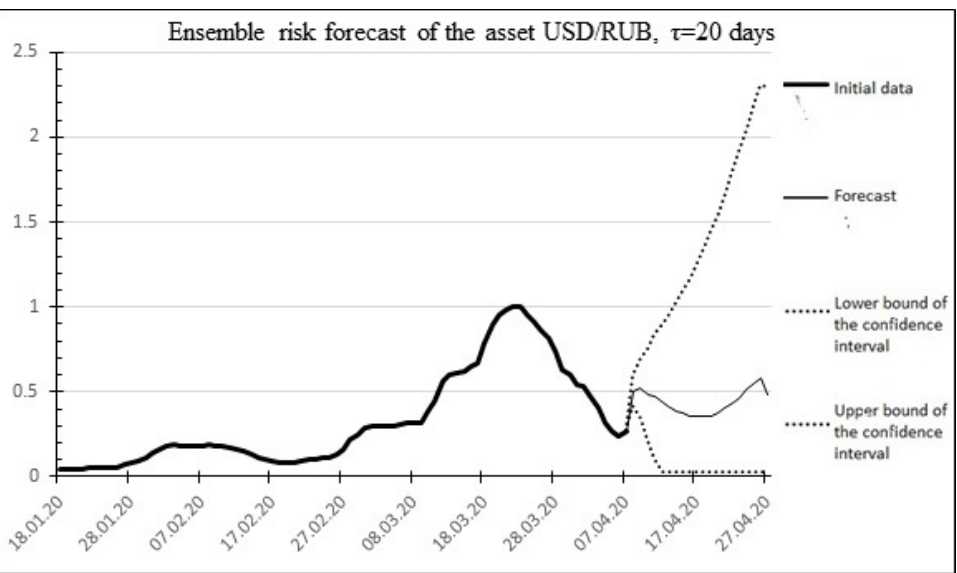
Figure 12. Aggregate ensemble risk forecast for the USD/RUB asset. Percentage error: